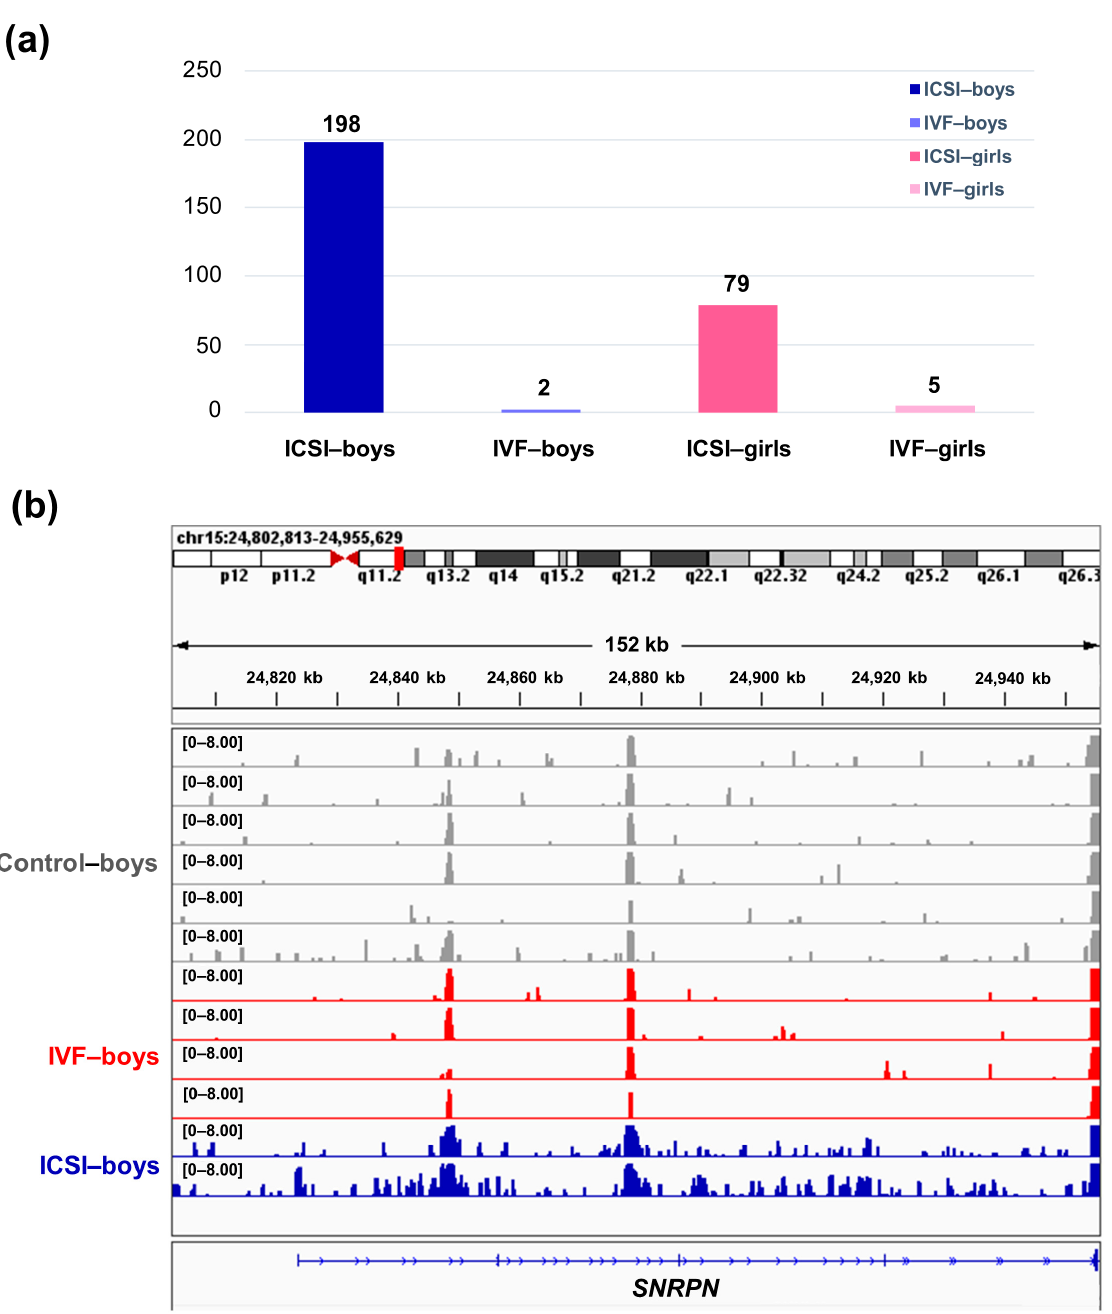
Figure 3. The ICSI-boys presented more genes with deH3K4me3 than IVF-boys, ICSI-girls, and IVF-girls. ( a ) The bar chart showed the comparison results of each gene promoter H3K4me3 read counts between natural conception-boys ( n = 6) vs. ICSI-boys ( n = 2), natural conception-boys ( n = 6) vs. IVF-boys ( n = 4), natural conception-girls ( n = 6) vs. ICSI-girls ( n = 4), and natural conception-girls ( n = 6) vs. IVF-girls ( n = 4). The comparison was performed via R package ‘edgeR’. The